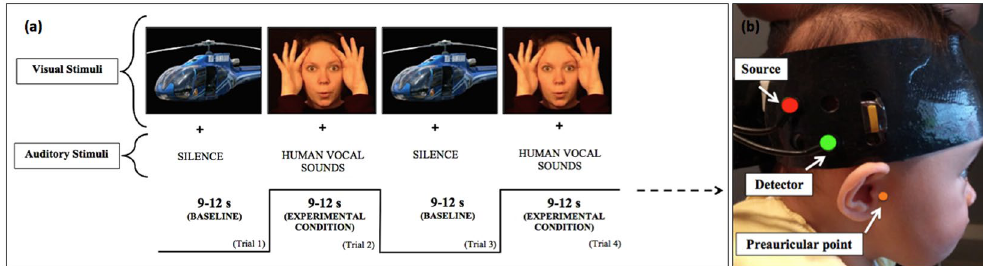
Figure 1. Experimental paradigm and set-up. ( a ) Order of stimulus presentation. ( b ) Image of mini-CYRIL optodes on a participant. A NIRS-MRI age appropriate co-registration map 28 was used to align the lower front of the array (marked with a yellow stripe) with the right preauricular anatomical landmark. This allowed the source-detector pair to be positioned over the right STS-TPJ, a region previously shown to be activated by viewing dynamic social stimuli 19